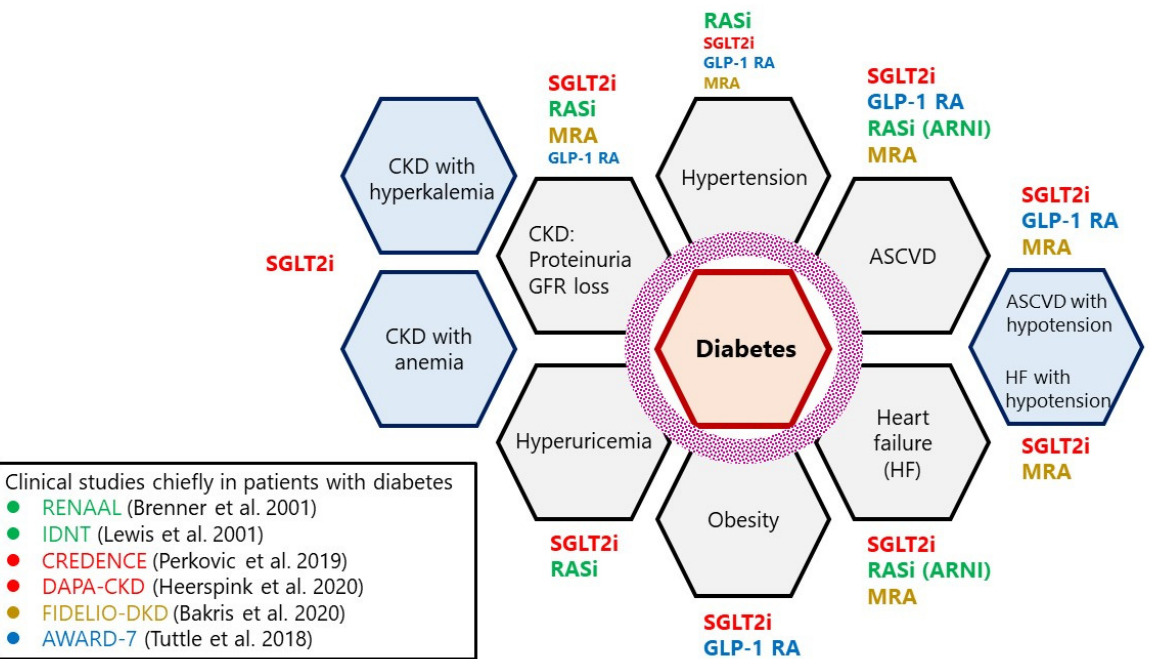
Figure 2. Four treatment drugs for DKD (RAS inhibitors, SGT2 inhibitors, MRAs, and GLP-1 RAs). Clinical studies chiefly in patients with diabetes, RENAAL [12], IDNT [13], CREDENCE [15], DAPA-CKD [16], FIDELIO-DKD [17], AWARD-7 [18]. Patients with diabetes are at an increased risk of comorbidities, such as hypertension, hyperuricemia, and obesity, as well as complications, such as CKD, ASCVD, and HF. RAS inhibitors are highly recommended in hypertensive patients; however, the other three treatment agents also exhibit mild blood pressure-lowering effects (approximately 2–3 mmHg). SGLT2 inhibitors and some RAS inhibitors, such as losartan and irbesartan, exhibit mild uric acid-lowering effects. SGLT2 inhibitors and GLP-1 RAs exhibit body weight-lowering effects that differ from those of other antihyperglycemic agents. RAS inhibitors, SGLT2 inhibitors, and MRAs can be used for preventing CKD (i.e., worsening kidney function decline and elevated albuminuria). Furthermore, GLP-1 RAs exhibit antialbuminuria effects, which are comparable to those of the other three agents, particularly in patients with diabetes and macroalbuminuria. Anemia and hyperkalemia are common complications observed in patients with advanced CKD. SGLT2 inhibitors exhibit potassium-lowering effects and have been shown to improve anemia.